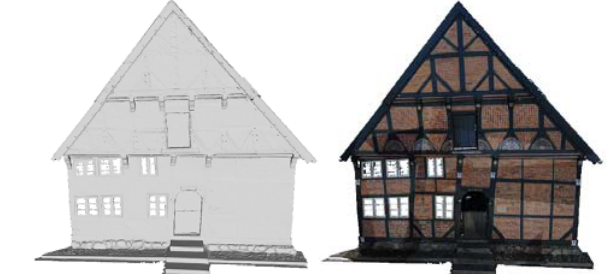
Figure 8. Superimposition of control points in the textured 3D model for geometrical quality control